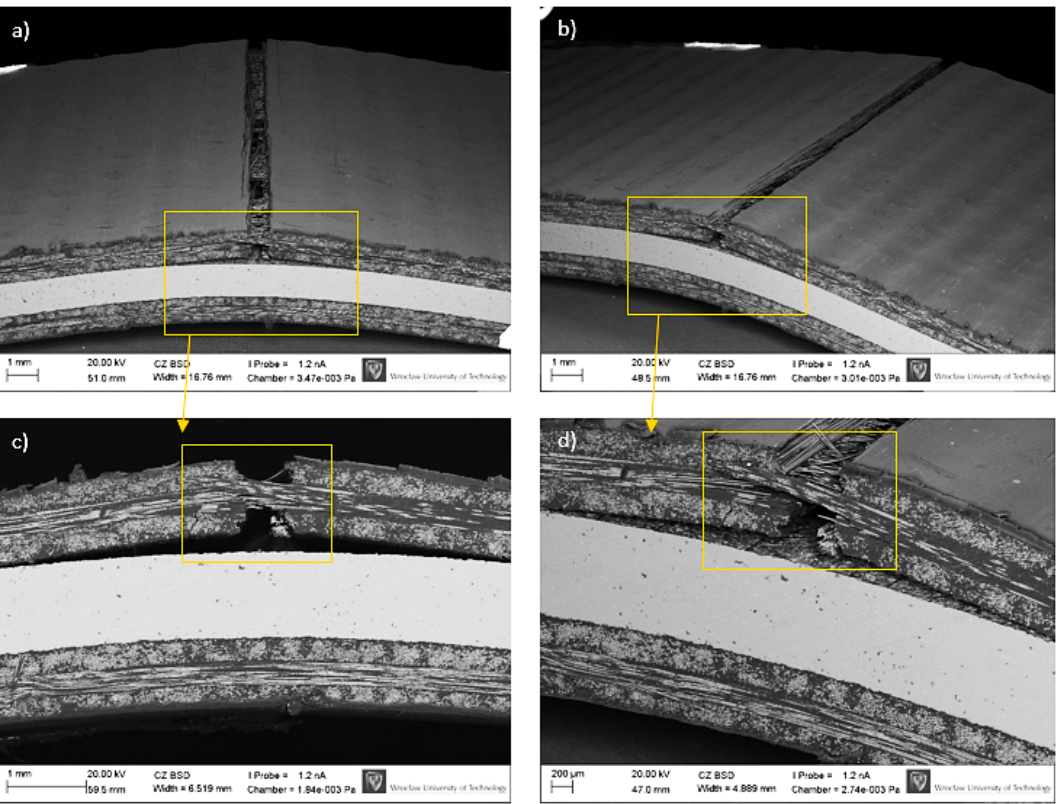
Figure 5. SEM images of the variant 1 (S1) sample damage during 3-point bending tests in perpendicular to the main axis direction (( a – d ) see description in the text).